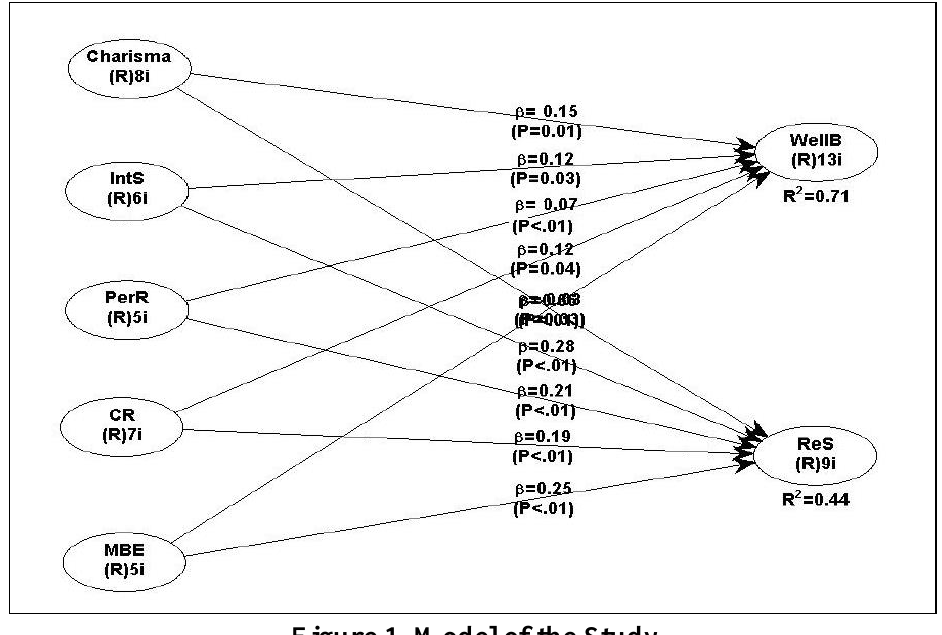
Figure.1. Model of the Study Source: Author’s own